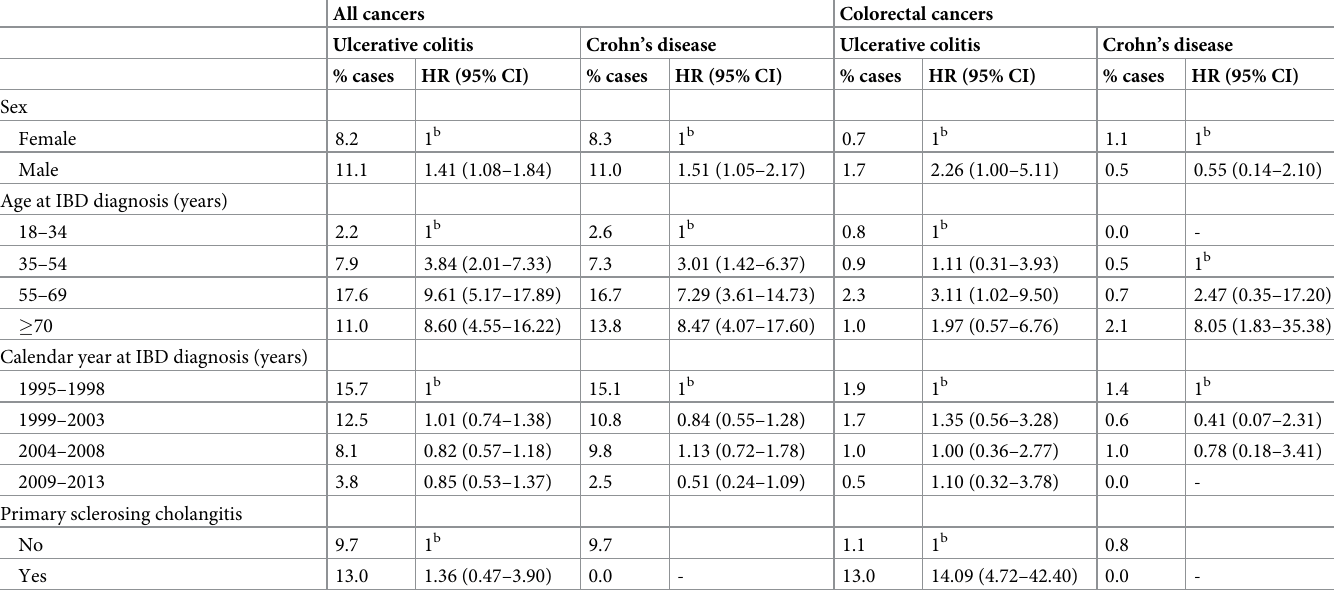
Table 3. Hazard Ratios (HRs) a for all and colorectal cancers and corresponding 95% Confidence Intervals (CIs) among patients with Inflammatory Bowel Disease (IBD) according to selected variables and IBD type. Friuli Venezia Giulia, northeastern Italy, 1995–2013.